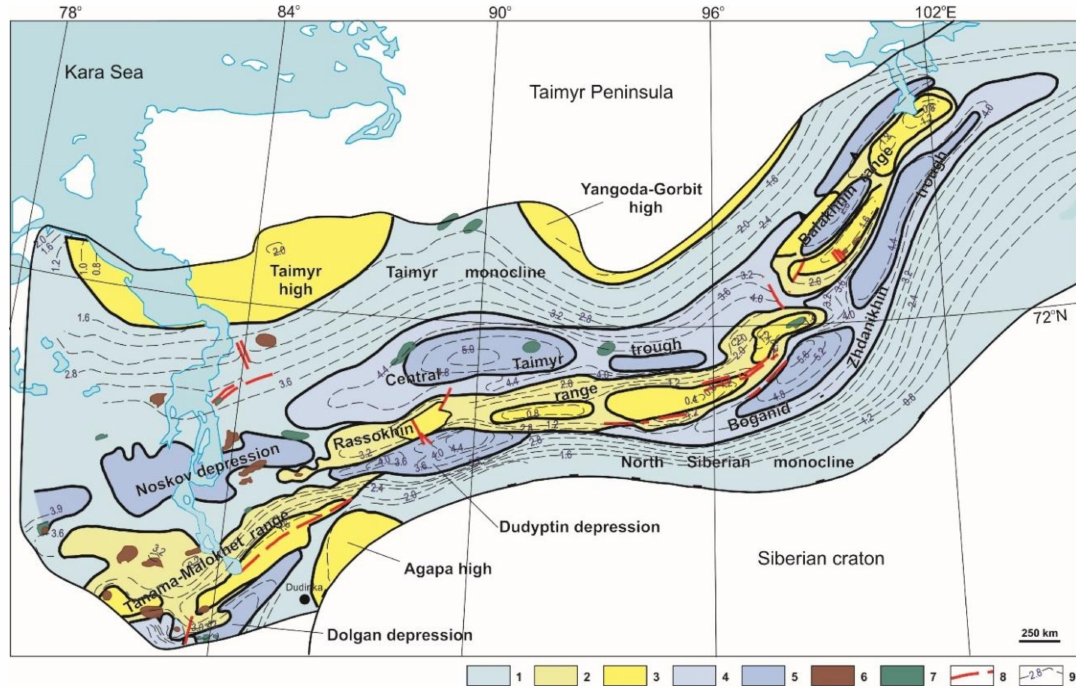
Figure 10. A fragment of the structural-tectonic map of the oil and gas bearing provinces of the Siberian craton from Reference [73] with our alterations. 1—Yenisei-Khatanga basin; 2—basement ranges; 3—basement high/swell; 4—first order negative structures; 5—second order negative